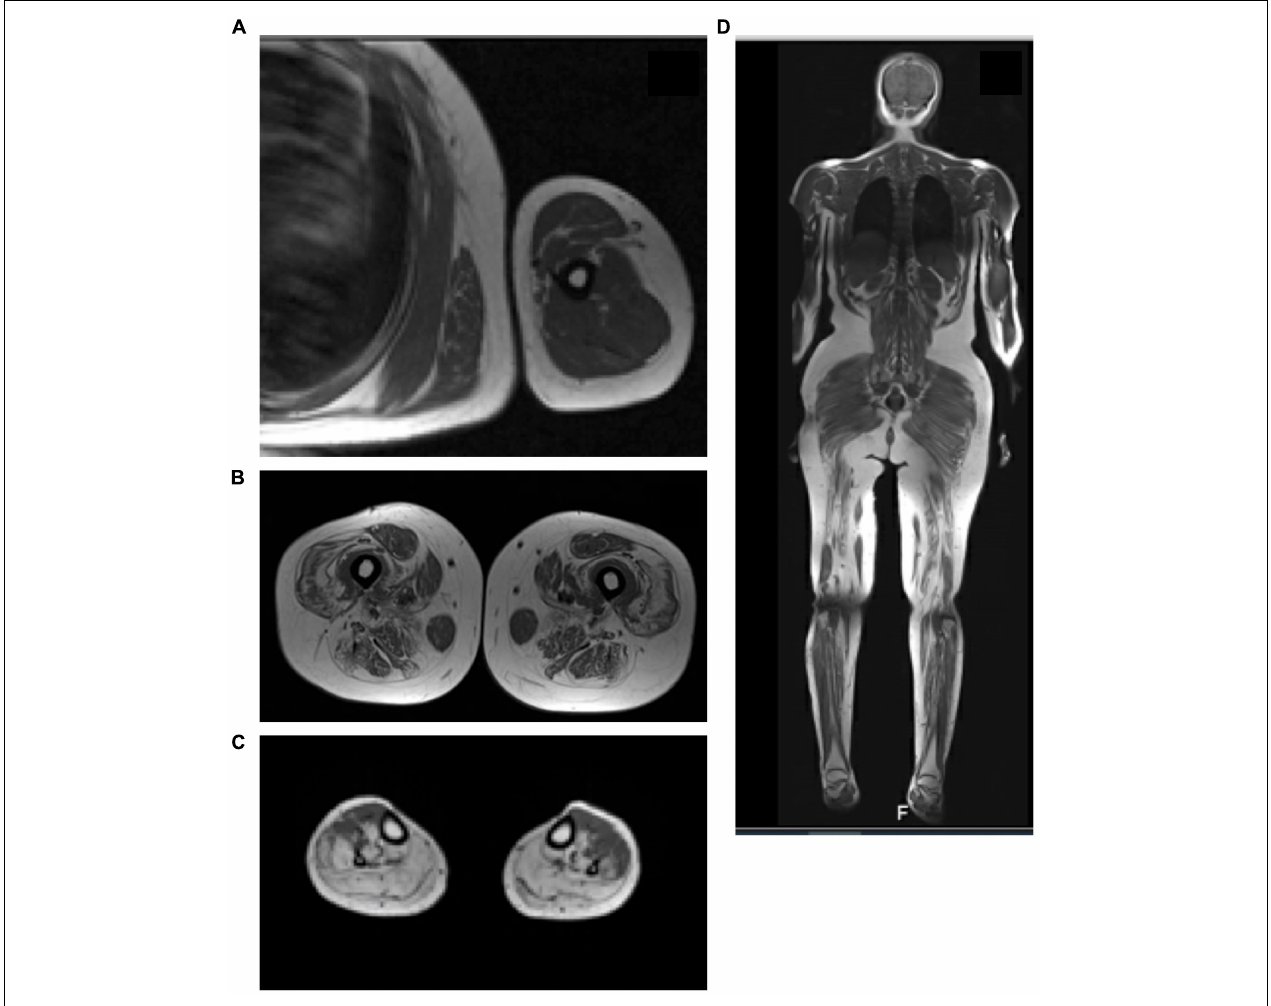
FIGURE 7 | MRI of the leg with active inflammation. (A) MRI T1 of the upper limb showed the evidence of mild feathery muscle edematous changes involving the deltoid muscle and the biceps brachii muscle. (B) T1 MRI of the high muscle showed diffused fatty infiltration of the high muscle bilateral with sparing of the Sartorius muscle and relative sparing of the abductor. (C) T1 MRI of the legs showed significant fatty infiltration of the posterior and lateral compartments of the legs with relative sparing of the anterior compartment. (D) Whole body MRI scan (T1-weighted scan) showed diffused feathery edematous changes involve the thigh and leg